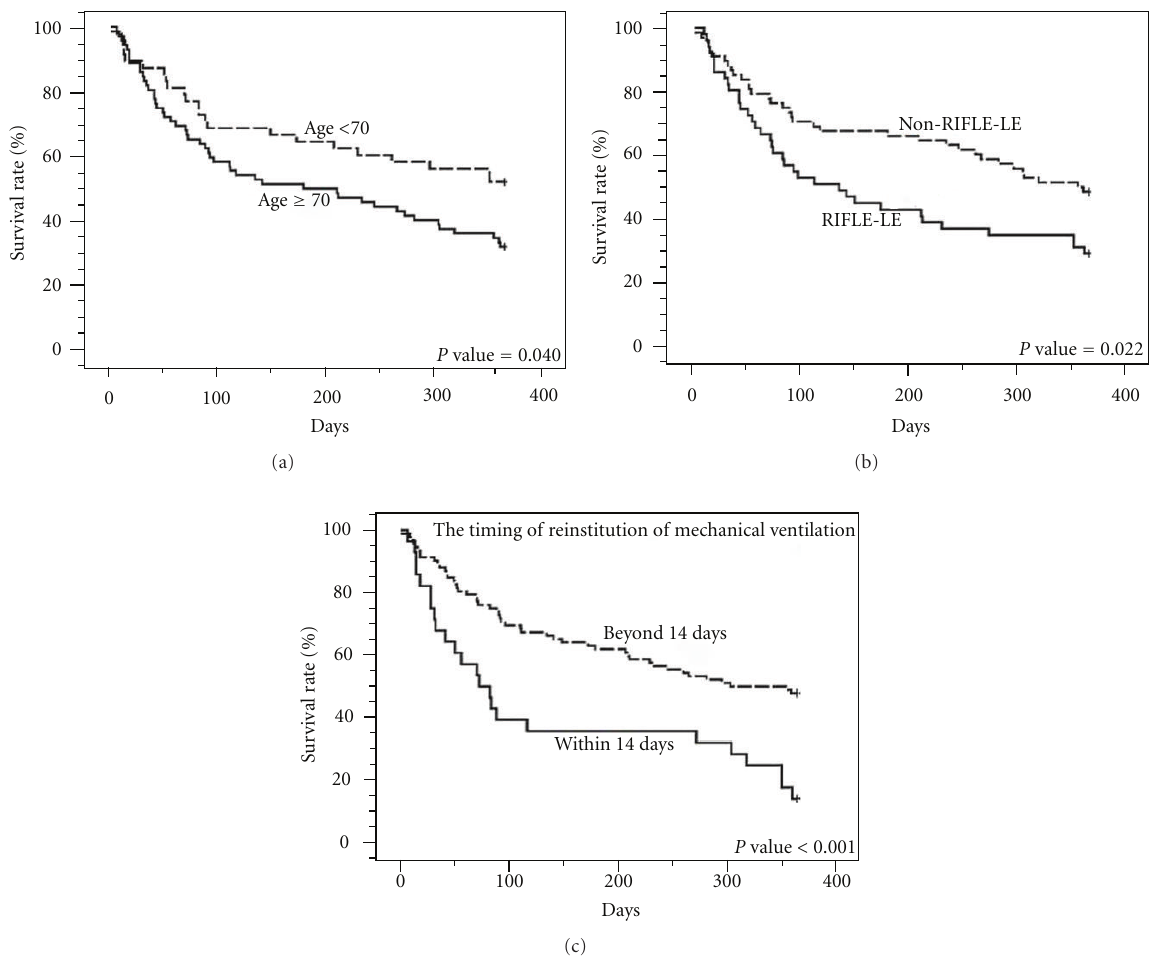
Figure 1: Kaplan-Meier analysis of prognostic factors for 1-year cumulative survival in 121 prolonged mechanical ventilation patients following successful weaning: age < 70 versus ≥ 70 years (a), RIFLE-LE versus non-RIFLE-LE (b), and the reinstitution of mechanical ventilation within 14 days versus beyond